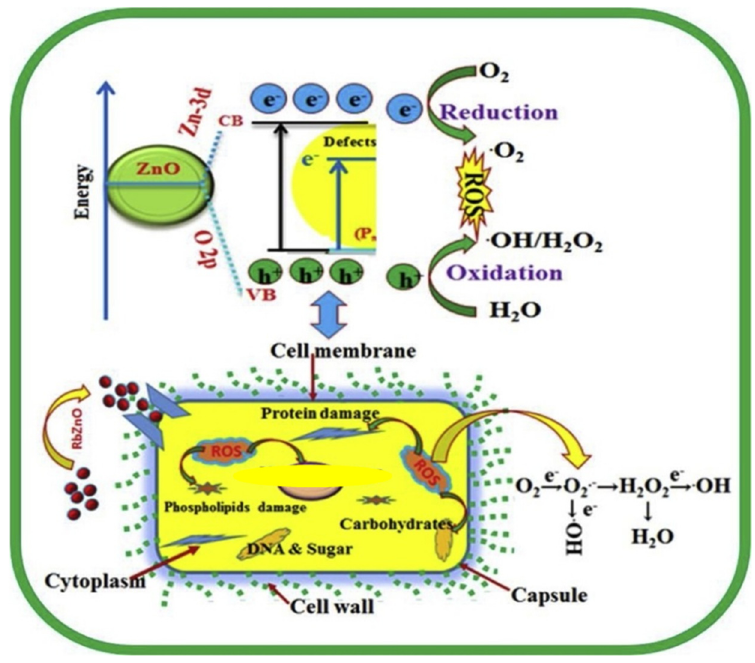
Figure 5. Schematic representation for antibacterial impacts of nanomaterials.